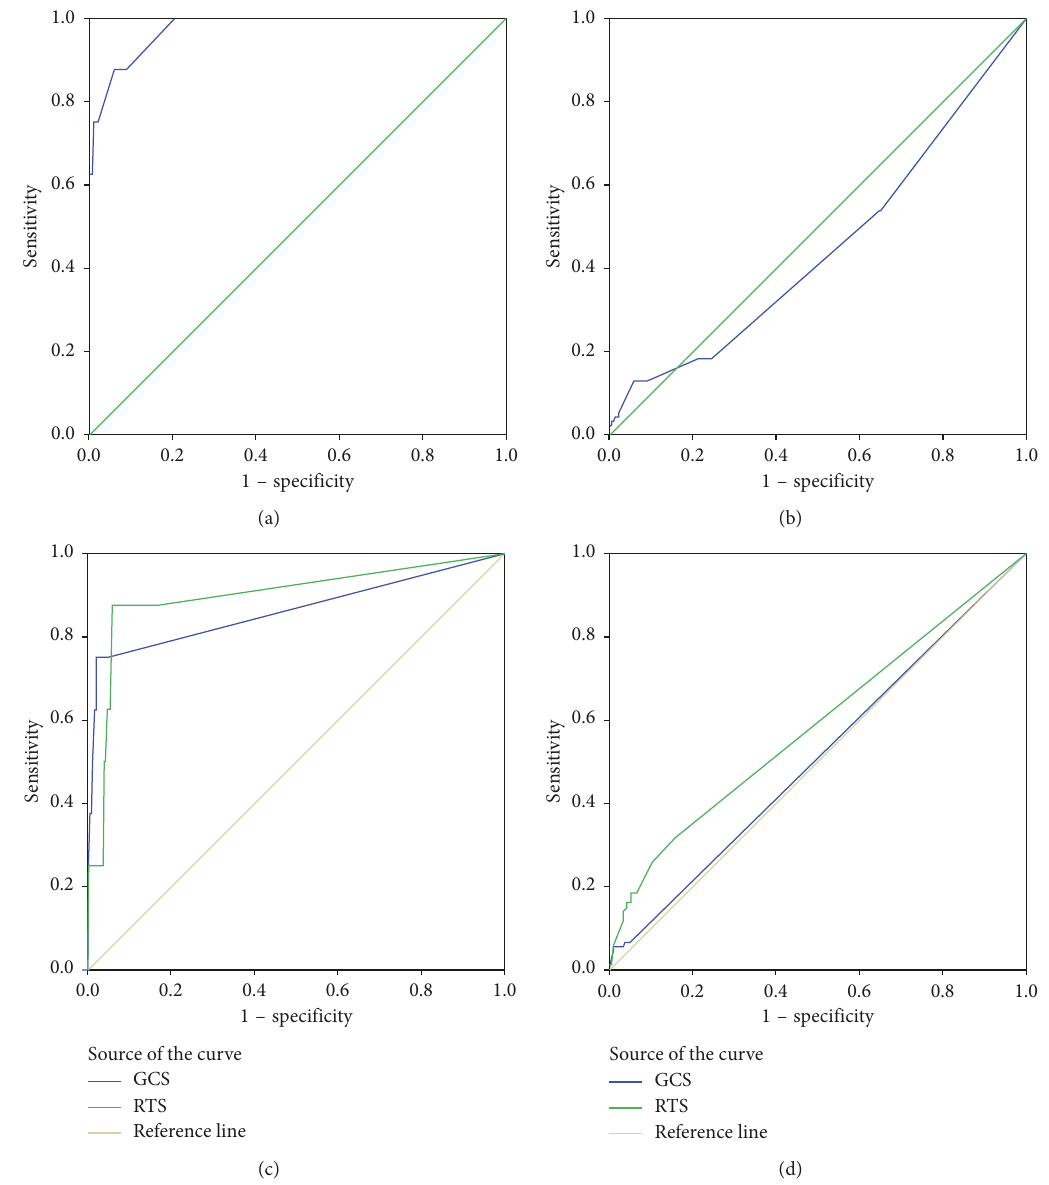
Figure 1: ROC curve of trauma scores to mortality and prolonged ICU stay. (a) ISS to mortality. (b) ISS to prolonged ICU stay. (c) GCS and RTS to mortality. (d) GCS and RTS to prolonged ICU stay.